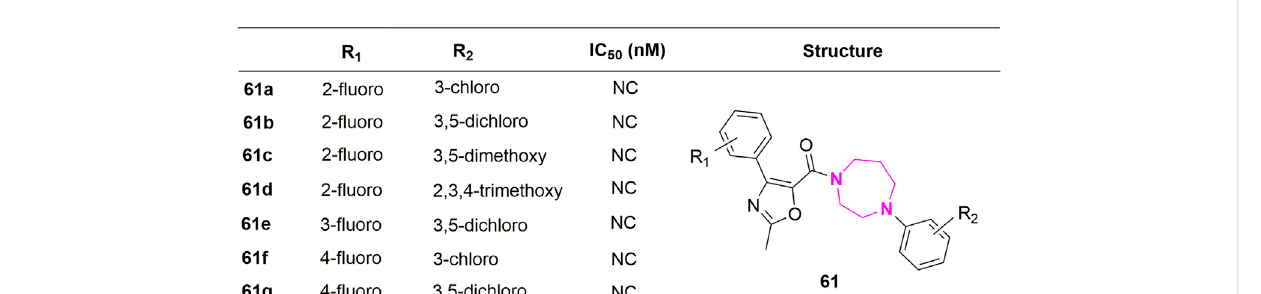
FIGURE 12 Structure and activity of homopiperazine analogues.